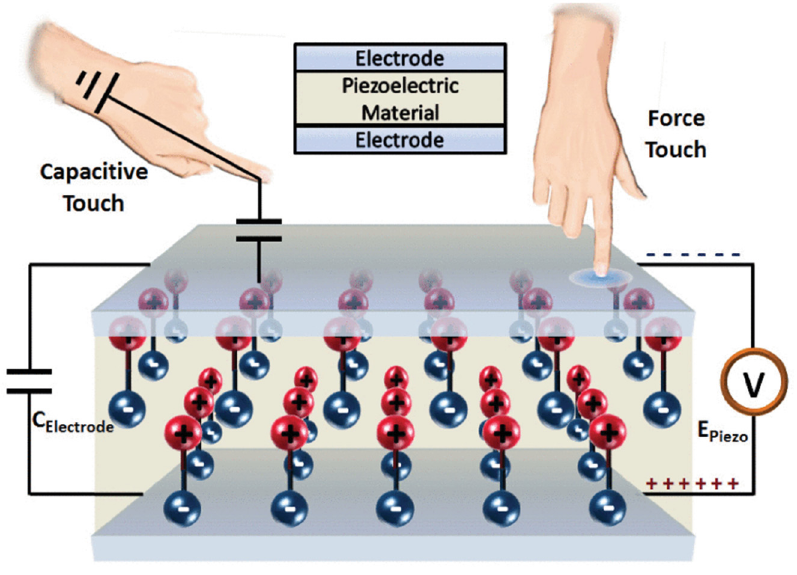
Figure 2. The sandwich architecture of the piezoelectric touch panel [43].